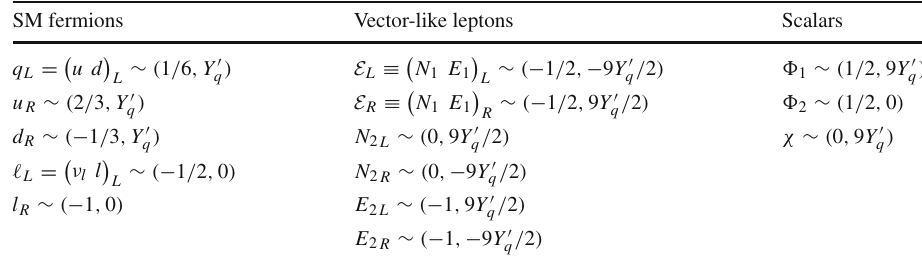
SM fermions Vector-like leptons Scalars (cid:4) (cid:5) ∼ ( 1 / 6 , Y (cid:2) ) u d q L = q L